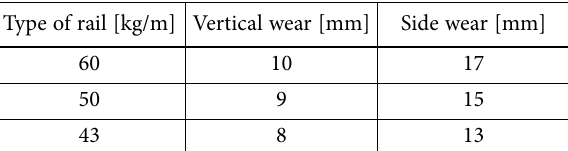
Table 2. Standards for severe rail wear defects